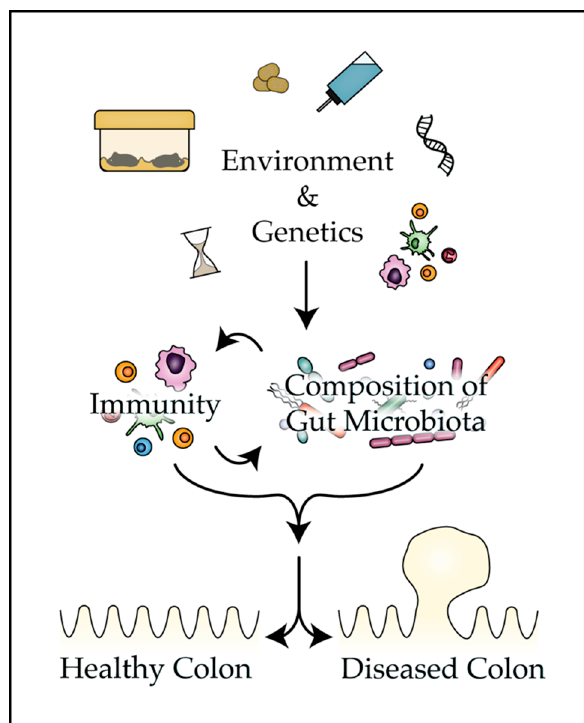
Figure 1. Many aspects of the murine environment can impact the composition of the gut microbiota, activity of the immune system, and ultimately the penetrance of disease phenotypes in mouse models of colon tumorigenesis.